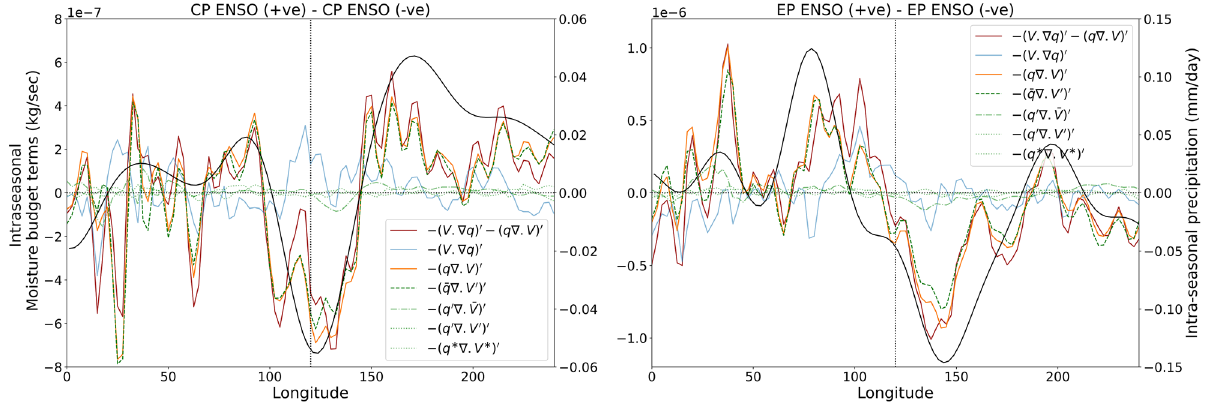
Figure 5. Differences in moisture budget terms in Eqs. (2 and 4) between the warm and cold CP-type ENSO phases (left panel). The red line denotes the horizontal moisture flux convergence [sum of horizontal advection (blue) and moisture convergence (yellow)]. The green lines are the four terms of horizontal moisture convergence in Eq. (4). We observed that the dashed green line denoting the convergence of mean moisture through intraseasonal winds have the largest contribution in intra seasonal moisture tendencies (vertical advection due to horizontal moisture convergence). The right panel shows the difference in moisture budget terms for warm and cold EP-type ENSO